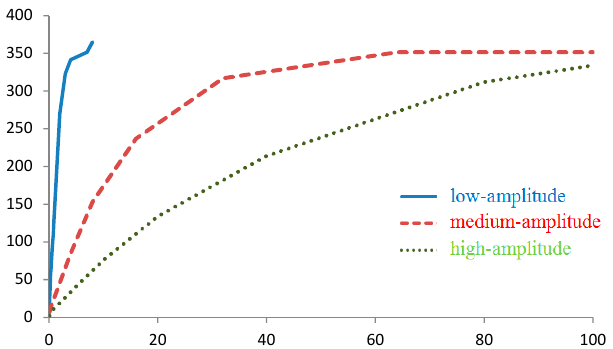
Figure 5. Dependence of the number of found potential points on the N potential route on the measurement error (mGal) for one route point when navigating by |𝑔̅| for the case of regions with low-, medium-, and high-amplitude gravity anomalies.